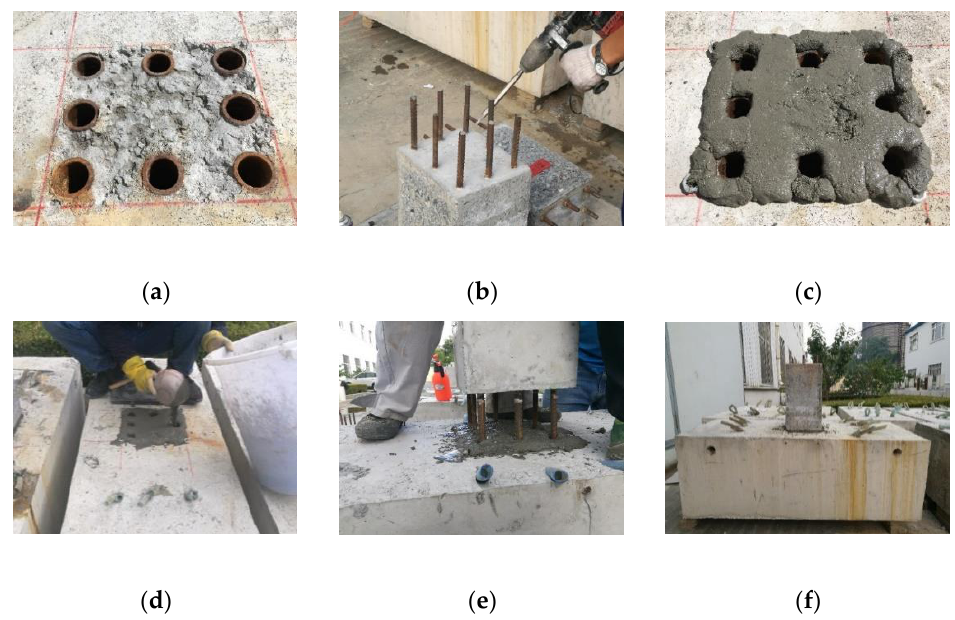
Figure 12. The main process of the second pouring. ( a ) Base cut hair. ( b ) Roughening of the F–T segment. ( c ) Laying the sealing material. ( d ) Artificial grouting. ( e ) Inserting freeze–thaw segments. ( f ) End of the assembly.